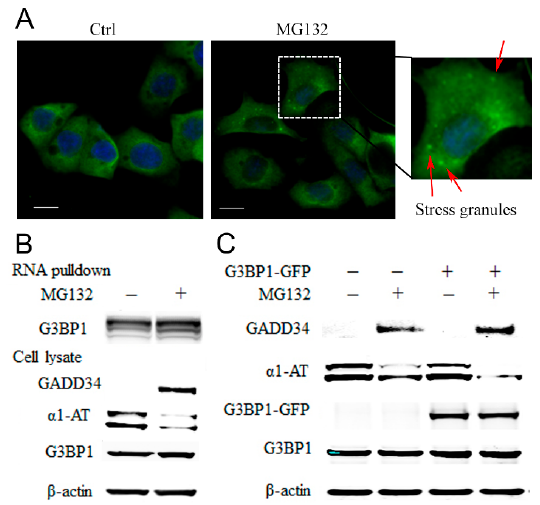
Figure 6. MG132 causes stress granule formation and promotes RNA binding proteins associated with α 1AT mRNA. ( A ) C3A cells were plated on type I collagen-coated glass coverslips and treated with MG132 for 2 h. The cells were stained with G3BP1 antibody and mounted using the Prolong Gold Antifade reagent with DAPI. The positive G3BP1 puncta which represent stress granule were denoted by an arrow (Scale bar = 10 µm). ( B ) Biotinylated α 1AT RNA incubated in 500 µg C3A cytoplasmic protein (Ctrl and MG132 treatment). The RNA-RBPs complex were pulled down with streptavidin agarose beads and applied for western blot analysis. ( C ) C3A cells were transiently transfected with empty vector or GFP tagged G3BP1 for 48 h and then treated with MG132. Cell lysates were analyzed by western blot analysis using indicated antibodies.